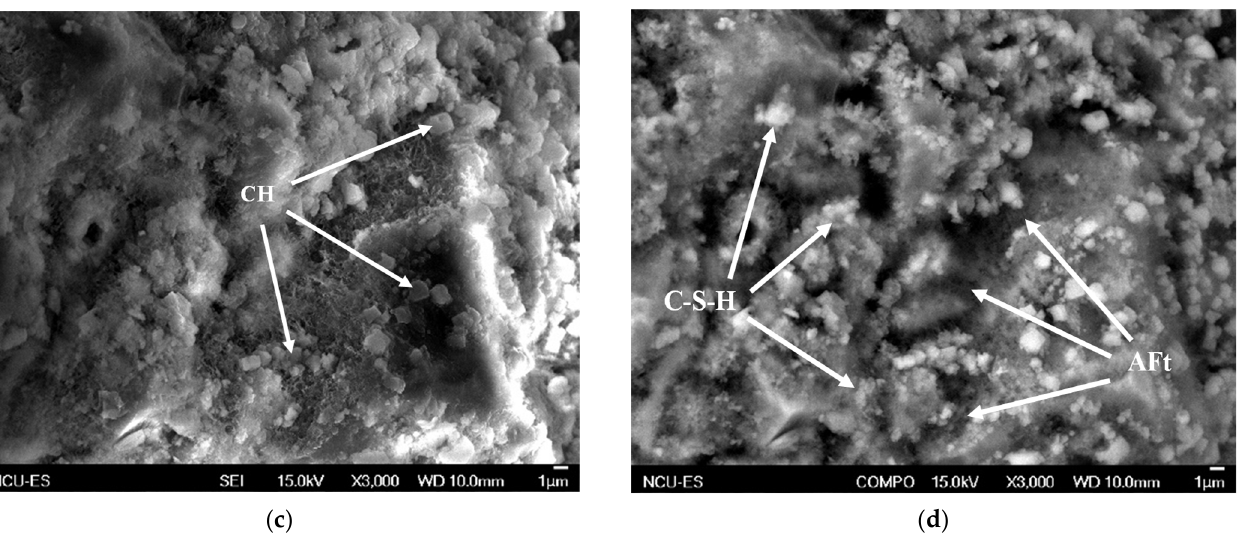
Figure 7. SEM micrograph of CFB-BFS blended paste under external sulfate attack for 180 days. ( a ) SEM micrograph of ESA products. ( b ) ESA products near the outer side. ( c ) ESA products (Ca(OH) 2 ) observed on the inner part. ( d ) ESA products (Aft and C-S-H) observed on the inner part.